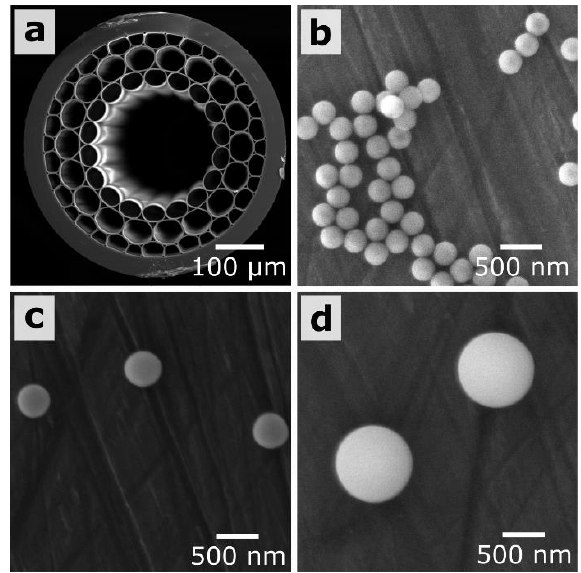
Figure 1. ( a ) Micrographs of scanning electronic microscopy (SEM) (Tescan, Bruno, Czech Republic)